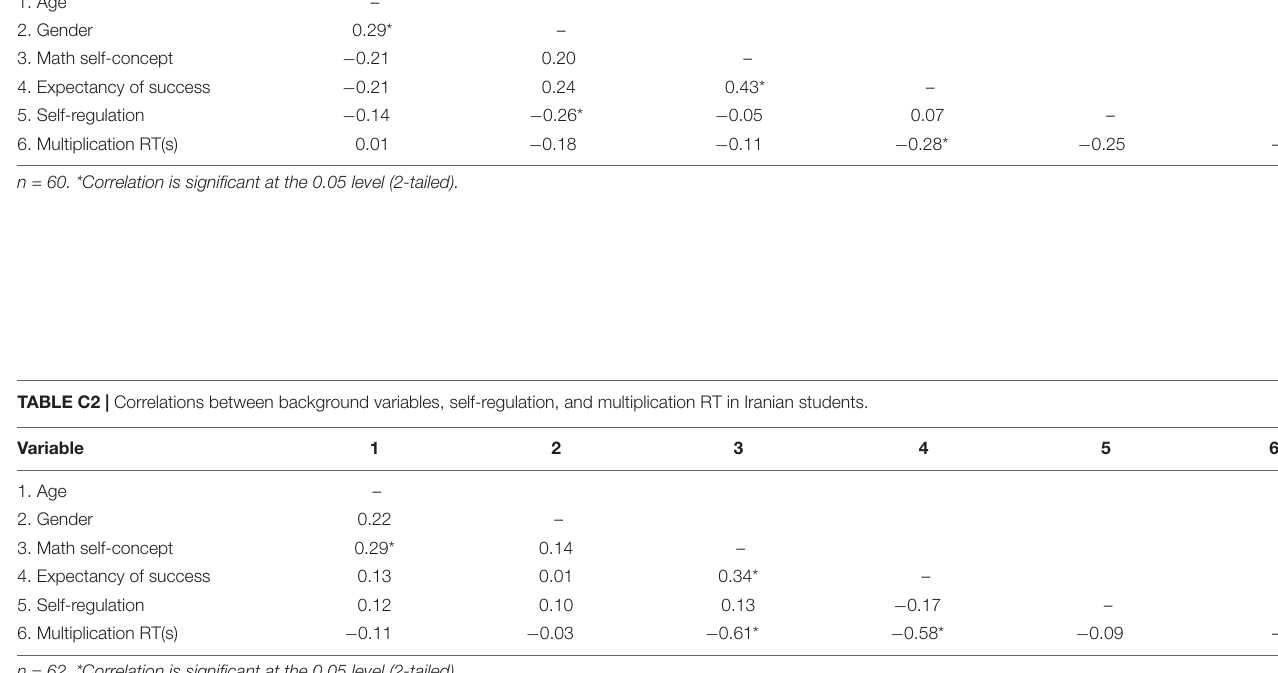
TABLE C1 | Correlations between background variables, self-regulation, and multiplication RT in German students. Variable